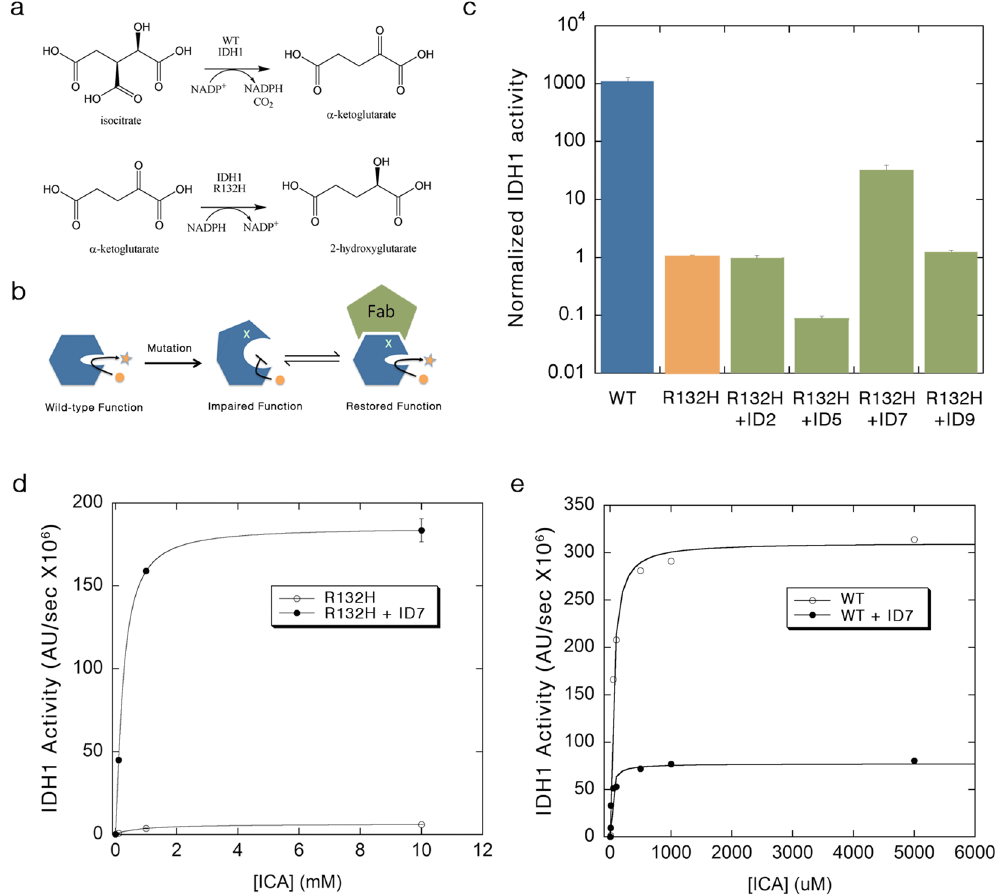
Figure 1. Rescuing the function of IDH1 mutant. ( a ) IDH1 catalyzes the NADP-dependent conversion of isocitrate to α –ketoglutarate. Mutations at R132 result in a neomorphic activity where NADPH is oxidized, and the oncometabolite 2-HG is produced. ( b ) A mutation (indicated by X) disrupts the conformation of the protein and results in an inactive enzyme. An engineered conformation-specific Fab that recognizes the active form of the enzyme can be used to reactivate the mutant enzyme by forcing it to adopt an active form. ( c ) WT IDH1 activity (blue) was compared to the activity of the IDH1 R132H mutant at 10 mM isocitrate in the absence (orange) or presence of excess Fabs (green). Fab ID7 results in a 30-fold enhancement of mutant activity (R132H activity set to 1). ( d ) The activity of the R132H mutant in the absence (open circles) and presence of ID7 (closed circles) was determined as a function of increasing isocitrate (ICA) concentrations. ( e ) In the presence of ID7 (closed circles), WT IDH1 shows a decrease in activity as well as a lower K M value (see Table 1).